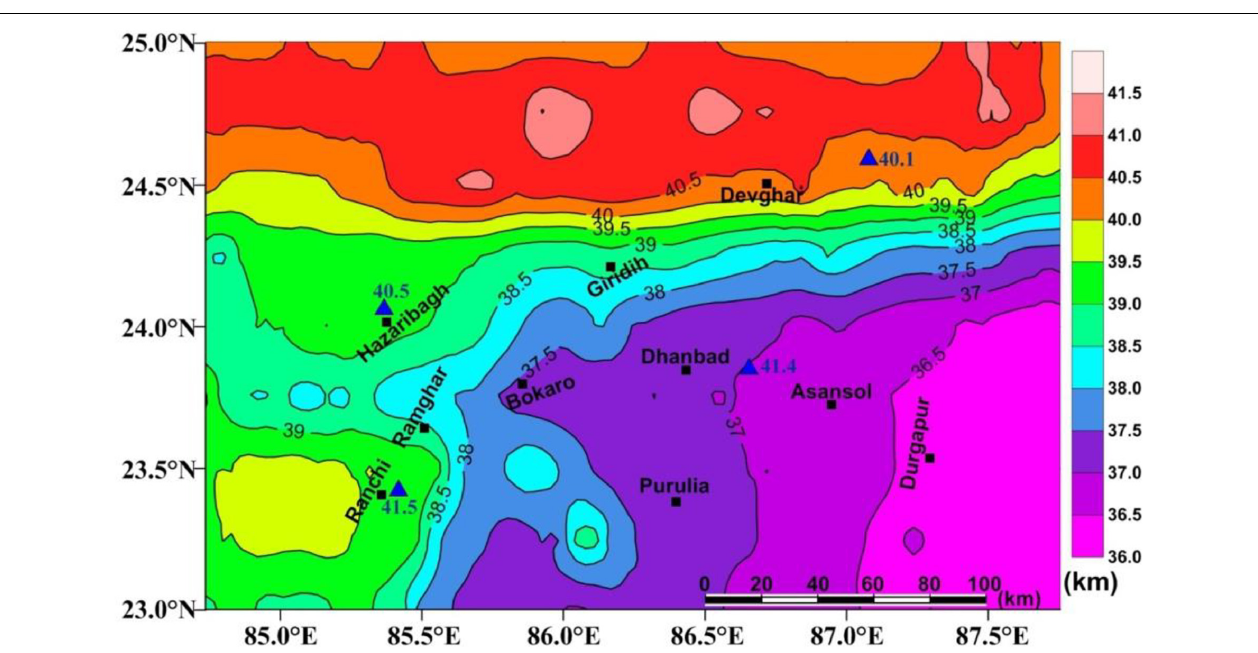
FIGURE 7 | Moho depth map deduced from spectral analysis technique and AIRYROOT program using a contour interval of 0.5 km (with color-coded index on the east). Blue triangle represents the location of broadband seismic stations in the EIS region and below their blue color texts represent the value of Moho depth calculated by receiver function analysis (Mandal and Biswas, 2016).